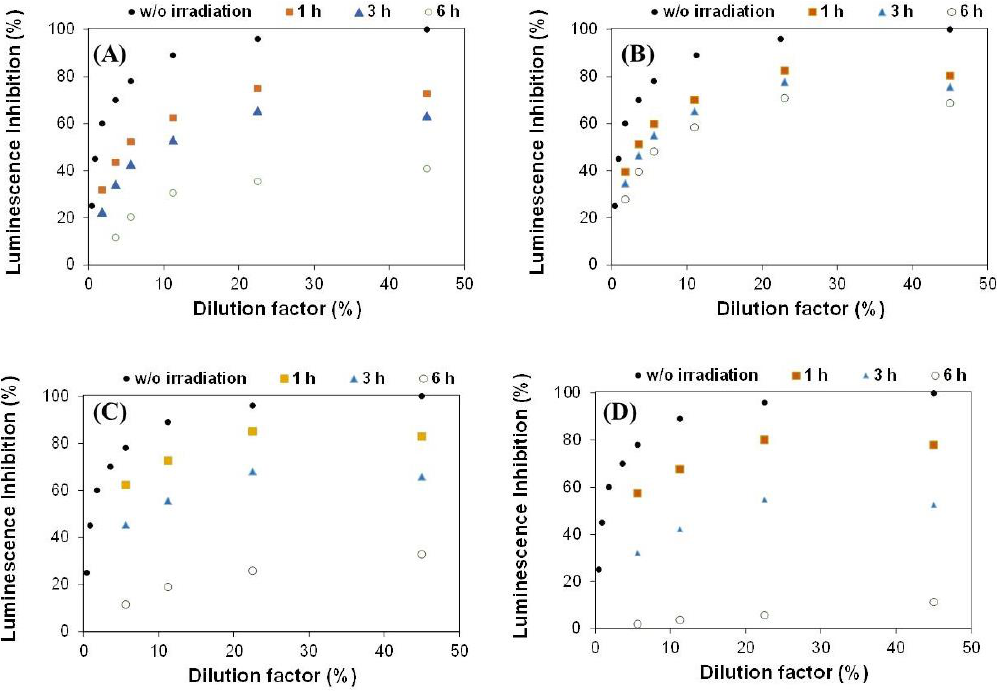
Figure 5. Luminescence inhibition of V. fischeri after exposure to cokemaking wastewater before ( w / o irradiation) and after the photochemical treatments during 1, 3, and 6 h of irradiation using: ( A ) UVC lamp; ( B ) UV-Vis lamp; ( C ) SimSolar lamp; ( D ) SimSolar lamp and TiO 2 as photocatalyst.